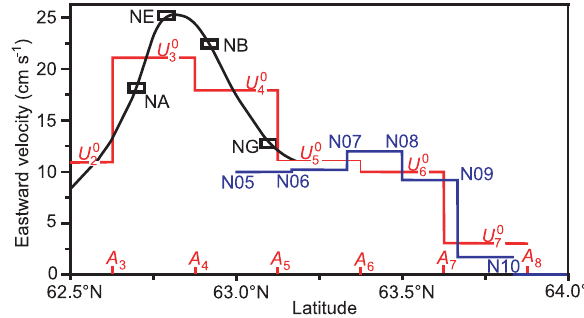
Figure 5. Values for the altimetry offset U 0 (red line) plotted to- k gether with average values for eastward surface velocity from the four long-term ADCP sites (rectangles) and from average geostro- phy (Table S2.4.3) (blue line). South of site NA, the velocity is esti- mated from various scattered observations (Fig. S2.4.4). The black curve shows a graphical interpolation from this region and between ADCP sites and values for U 0 , U 0 , and U 0 are averaged from these. 2 3 4 The value for U 0 is a combination of ADCP site NG and geostro- 5 phy between N06 and N07 (blue line). Values for U 0 and U 0 are 7 6 based on geostrophy combined with deep current measurements (Table